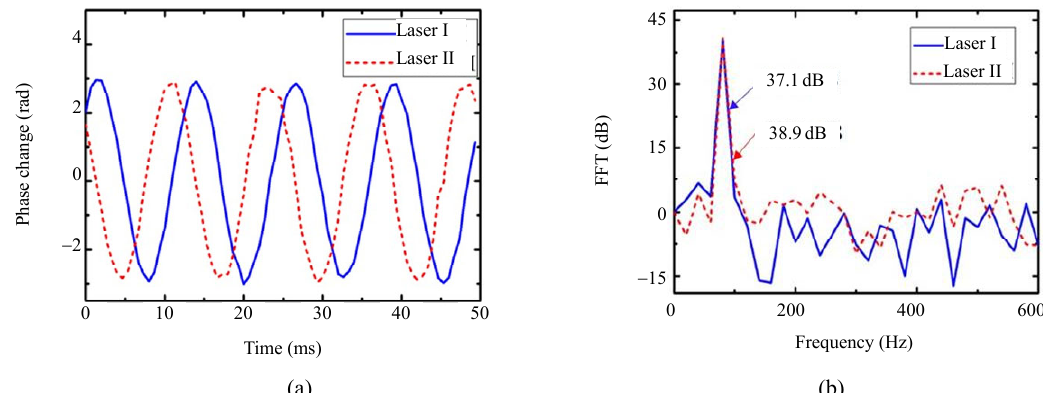
Fig. 4 Comparison of recovered external vibration signal of Laser I and Laser II ( ∆ z = 30 m): (a) the time domain waveforms and (b) the corresponding FFT of the vibration